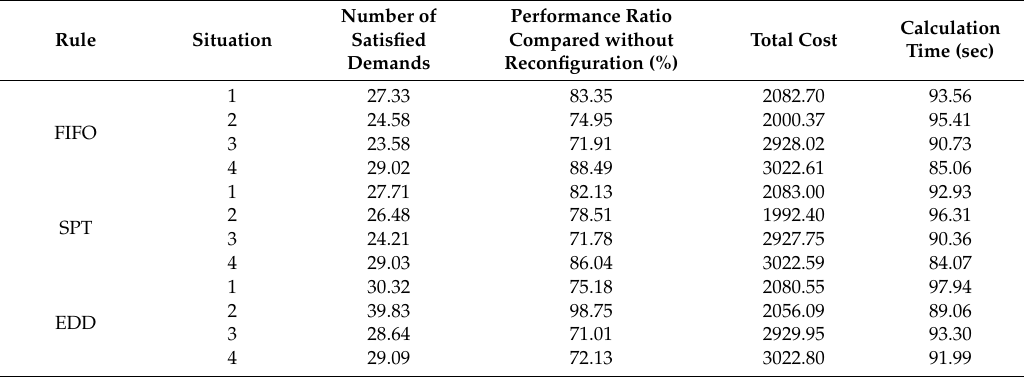
Table 9. Experimental result according to scheduling rule and reconfigurable